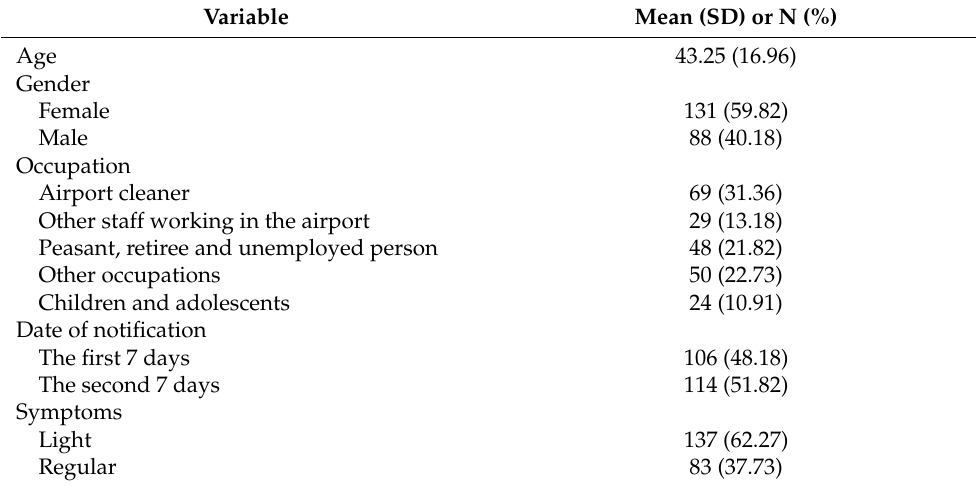
Table 1. Basic Characteristics of Confirmed Cases of COVID-19 in Nanjing from July 20 to August 2 in 2021 (N =